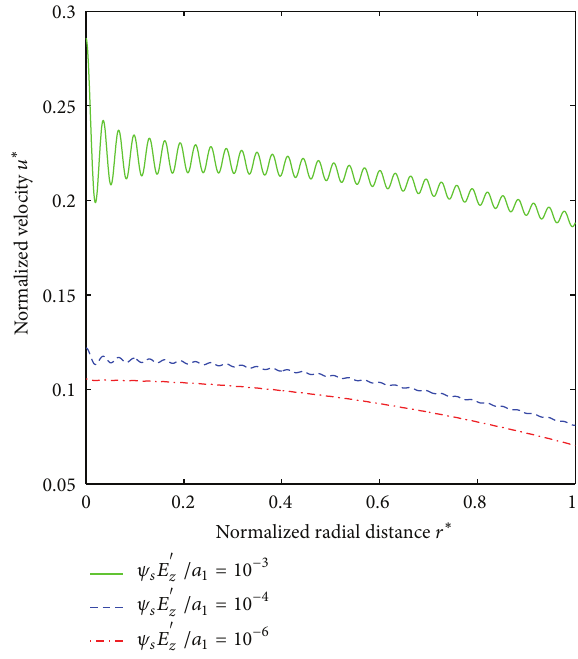
Figure 6: Influence of 𝐾 value on the velocity profile at a typical time 𝑡 ∗ = 𝜃/2𝜋 , obtained with 𝜓 𝑠 𝐸 󸀠 𝑧 /𝑎 1 = 10 −3 , 𝑙 ∗ = 1 .